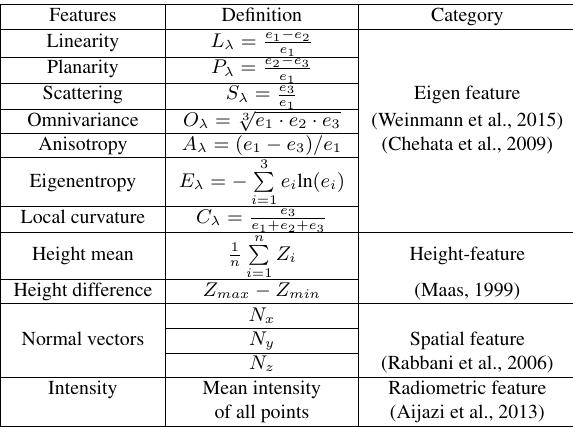
Table 1. List of totally used